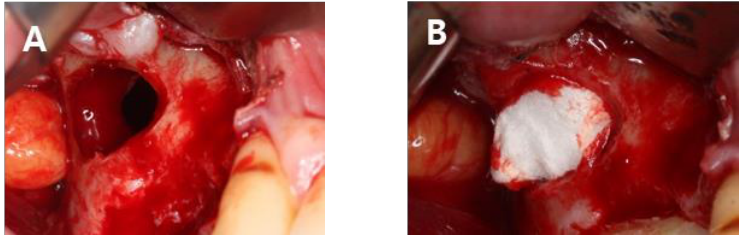
Figure 2. Large perforation of sinus membrane during sinus floor elevation procedure. ( A ) Large perforation of membrane (>10 mm). ( B ) Insertion of collagen plug (CP).